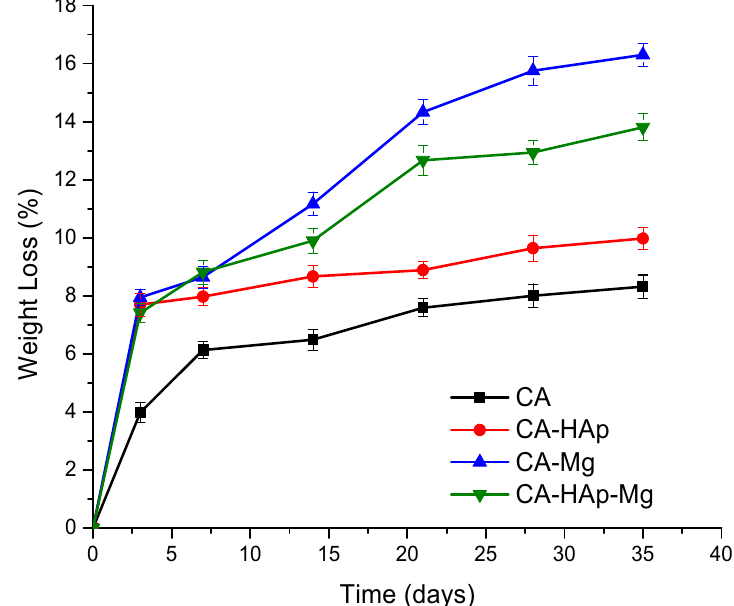
Figure 11. Degradation profile of the experimental samples calculated by weight loss over a period of 35 days of immersion in PBS solution.